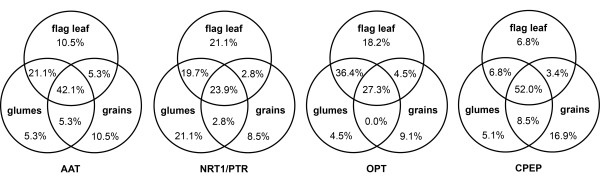
Venn diagrams showing organ-specific expression of N transporters and cysteine peptidases.